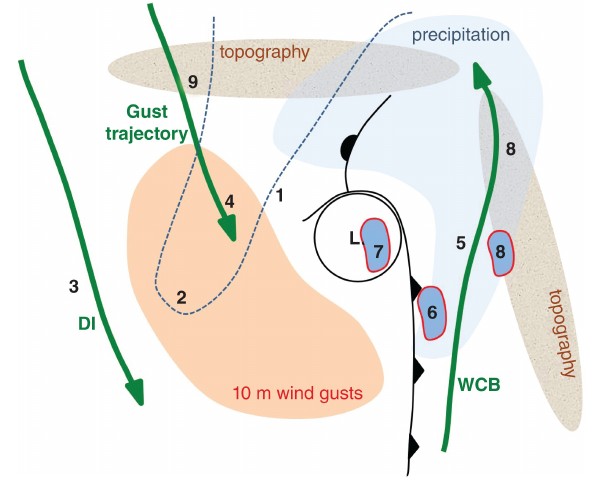
Figure 3. Schematic illustration of possible features related to com- bined precipitation and wind impact of a cyclone in the Mediter- ranean, based on the five events studied in Raveh-Rubin and Wernli (2016). Note that this schematic does not represent any in- dividual event but rather summarises the variable possible features of importance. The cyclone centre is denoted by the letter “L”, ac- companied by a cold and a warm front. Shading shows areas with precipitation impact (light blue) and with 10m gust impact (light red). Areas with convection (and thus co-located precipitation and wind gust impact) are shaded blue and encircled by a red line. High topography is represented by grey regions. The 320K 2-PVU con- tour is shown as a dashed line, and typical WCB, DI and gust tra- jectories are denoted as green arrows. The numbers mark the lo- cation of the following: (1) a prominent upper-level feature (PV streamer/trough/ridge), (2) tropopause fold and downward momen- tum transfer, (3) DI trajectories around high gusts, (4) low-level gust trajectory, (5) WCB slantwise ascent associated with precipi- tation, (6) convective precipitation at cold front, (7) convective pre- cipitation in cyclone centre, (8) orography enhancing precipitation (and/or convection), and (9) orography accelerating gust trajecto- ries. Reprinted from Raveh-Rubin and Wernli (2016) with permis-